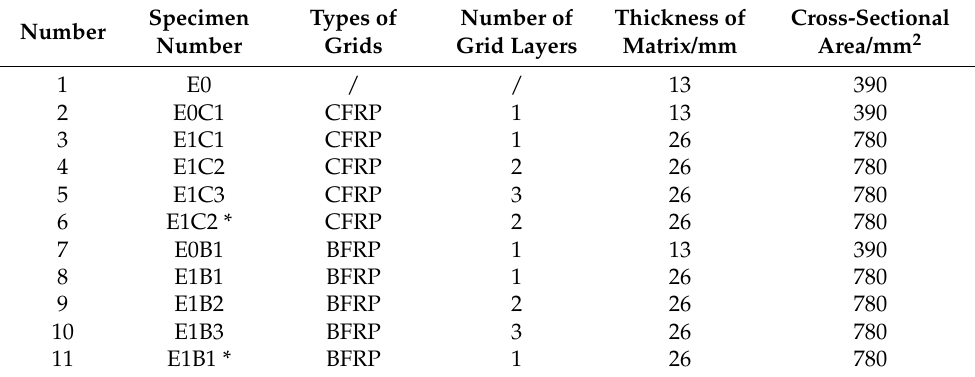
Table 1. FRP grid-reinforced ECC specimen design table.